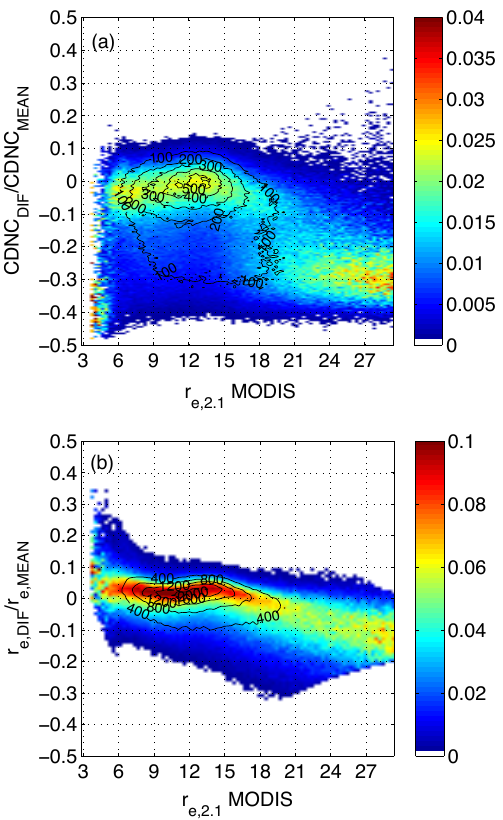
Figure 5. Two-dimensional histograms between relative CDNC differences and effective radius at 2.1µm bands (a) and between relative effective radius differences and effective radius at 2.1µm bands (b) . The color bar represents the normalized pixel number of each effective radius bin. Solid circle lines are isolines of the pixel